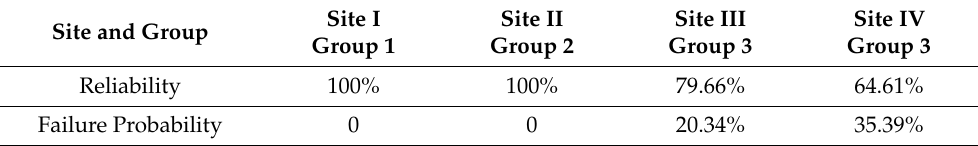
Table 7. Reliability and failure probability for rare earthquakes.